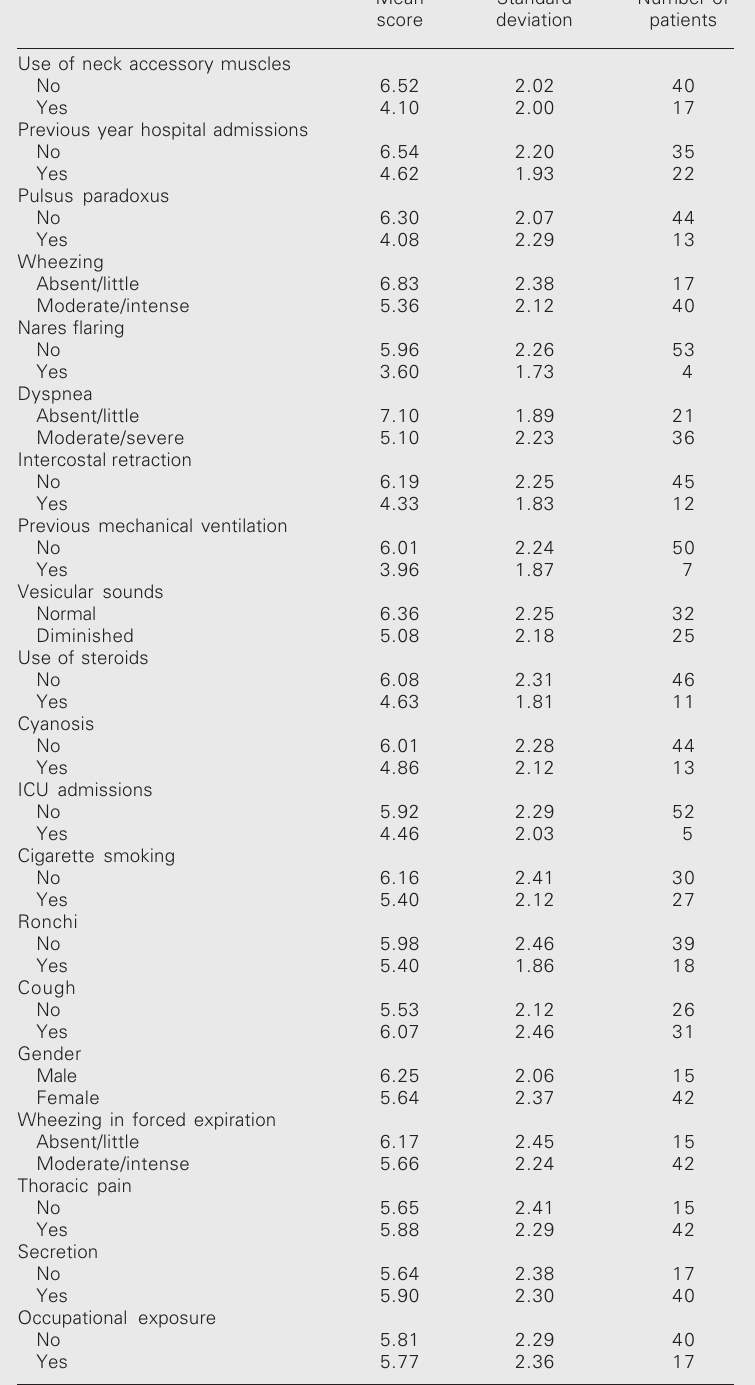
Table 2. Categorical variables obtained in medical history and physical examination and physician score.